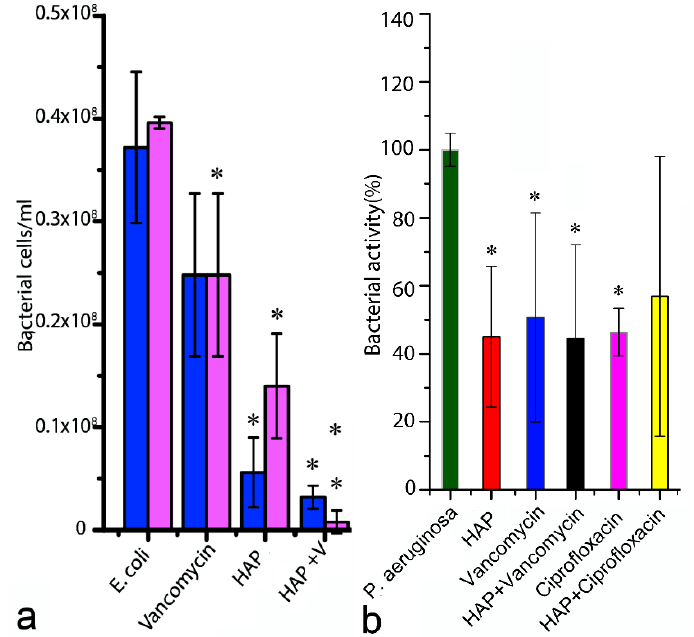
Figure 9. A difference in ( a ) the number of E. coli bacteria per cm 3 in LH broths; and ( b ) bacterial viability in the biofilm of P. aeruginosa following overnight incubation with pure HAP pastes, with pure antibiotics (ciprofloxacin or vancomycin) or with HAP pastes loaded with antibiotics. Data points significantly different from the untreated controls ( E. coli , P. aeruginosa , p < 0.05) are topped with an asterisk (*).